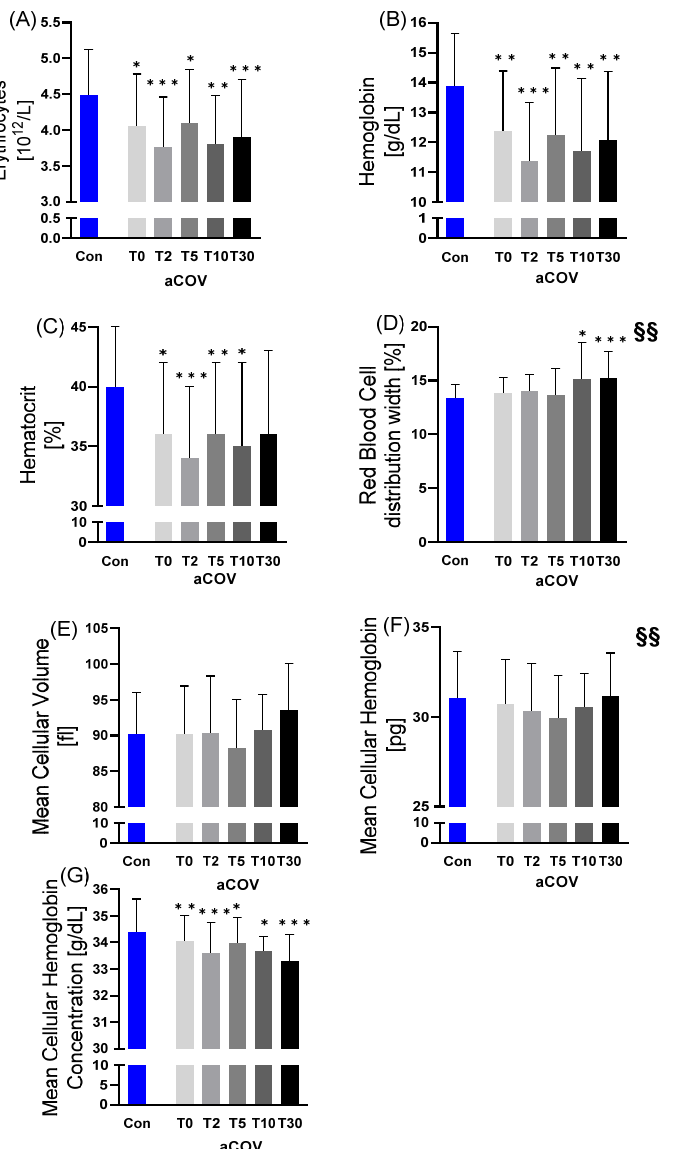
Figure 2. Red blood cell (RBC) variables assessed for acute COVID-19 infected individuals (aCOV) at different time points at the intensive care unit (T0 hospital admission; T2 day 2; T5 day 5; T10 day 10; T30 day) compared to healthy controls (Con). While ( A ) RBC concentration, ( B ) Hemoglobin (Hb) concentration, ( C ) Hematocrit (Hct), and ( G ) MCHC were decreased in aCOV compared to Con, ( D ) RDW (at T10 and T30) showed increased values. ( E ) MCV and ( F ) MCH of aCOV were not different compared to Con. A change of values over time was observed for RDW (increase) and MCH (U-shaped). * p ≤ 0.050; ** p ≤ 0.010; *** p ≤ 0.001 compared to Con; §§ p ≤ 0.010 changes over time in aCOV. In aCOV, MCH (J-shaped; p < 0.010) and RDW (increasing; p < 0.010) showed signifi- cant changes during the 30 days of